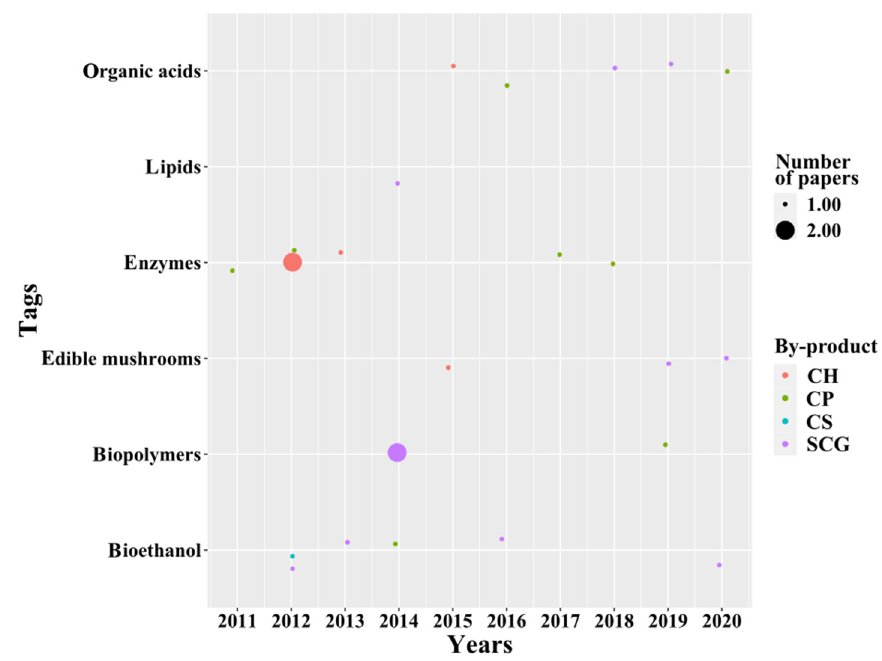
Figure 8. Temporal analysis of microbial transformation applications.